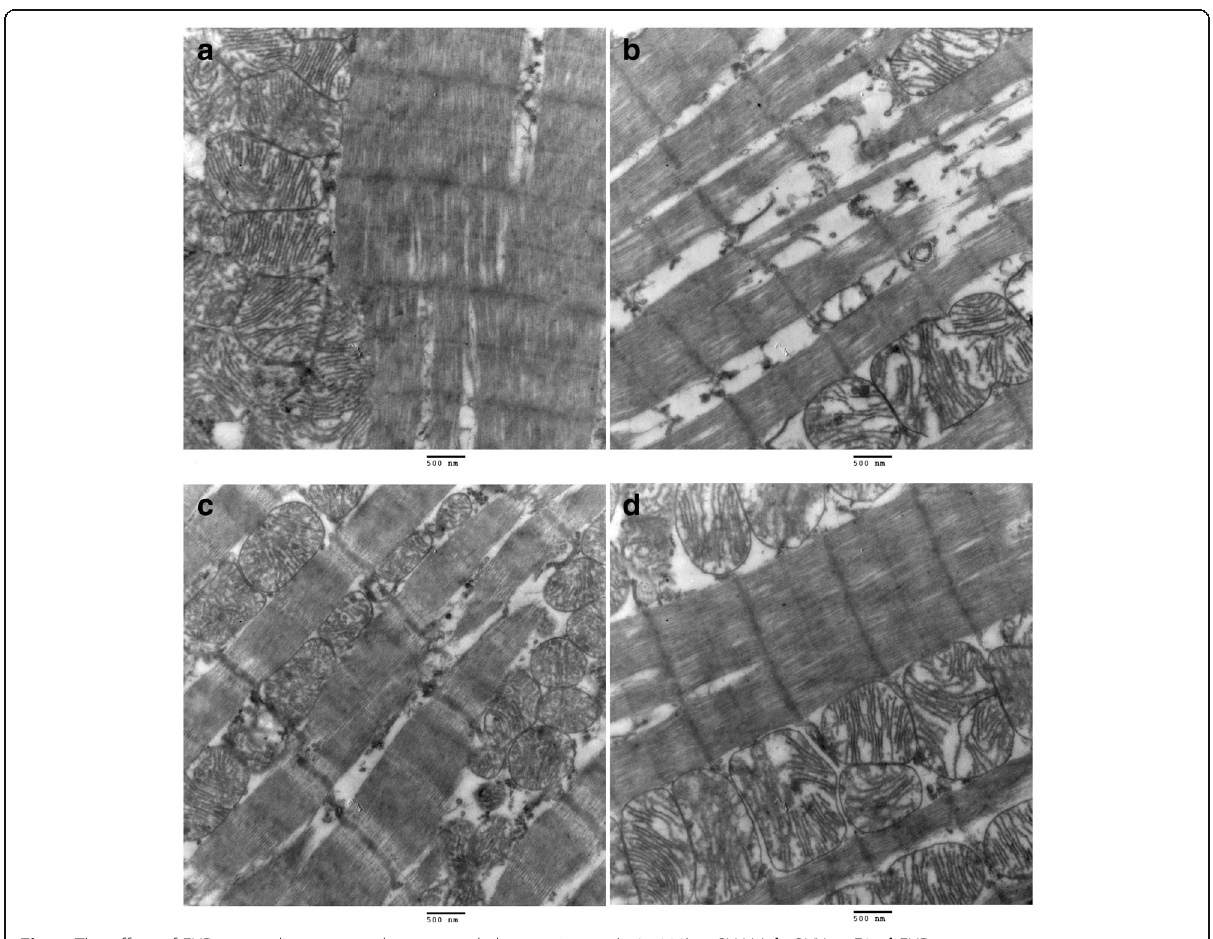
Fig. 5 The effect of EXD on cardiomyocyte ultrastructural changes in rats (× 25,000). a SHAM; b OVX; c : E2; d EXD